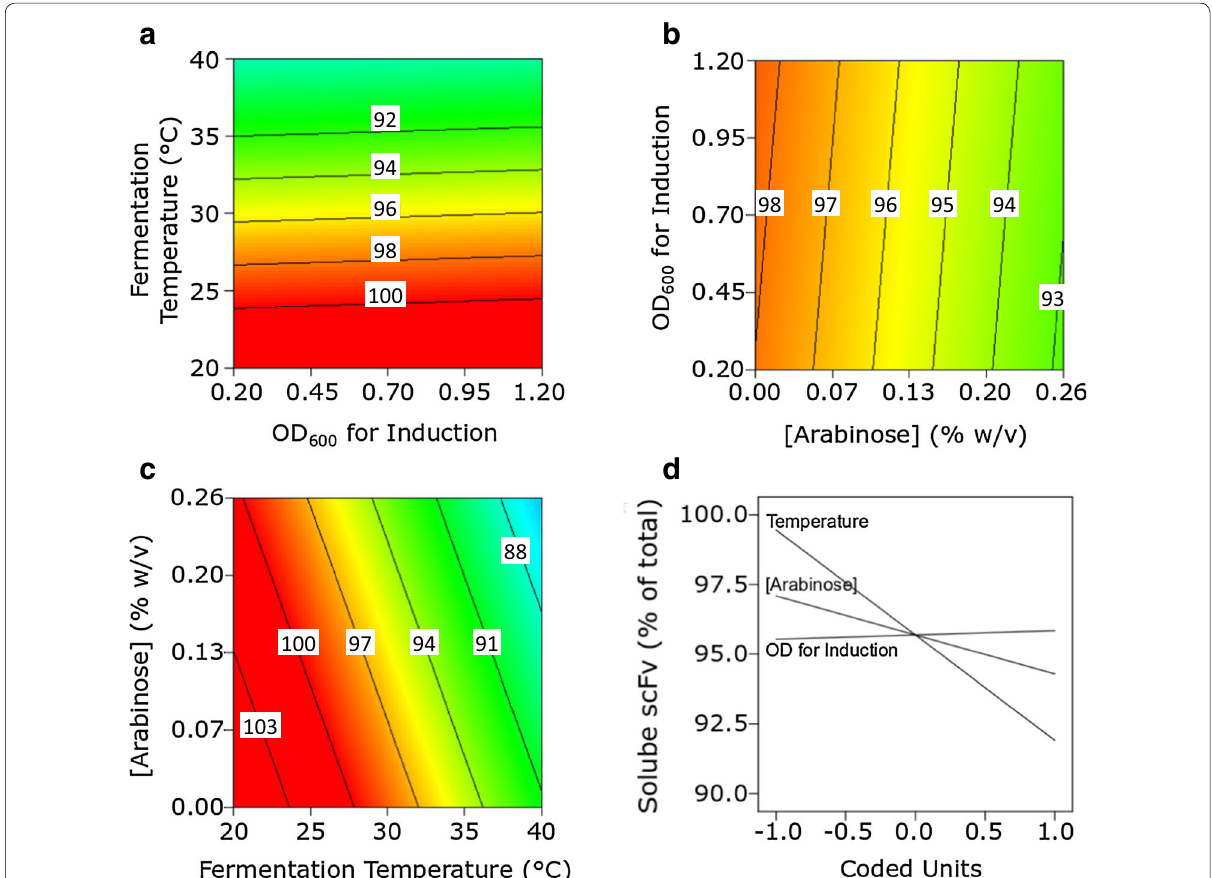
Fig. 4 Response ( a – c ) and perturbation ( d ) plots for the percentage solubility of PelB sp -scFv. Response plots show the response of two factors; the third invariant factor is set at level ‘0’. Units in response plots are µg scFv mL − 1 culture h − 1